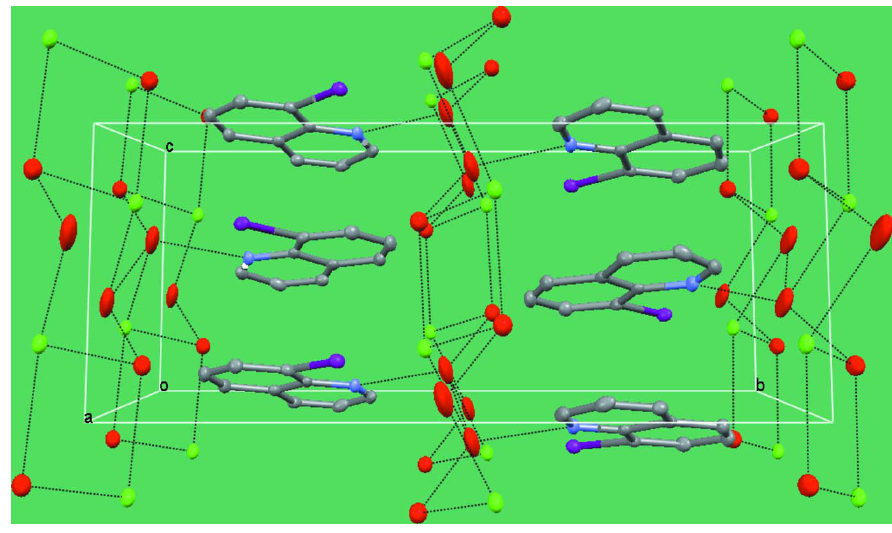
The crystal structure of 8-iodoquinolinium chloride dihydrate, viewed approximately along the a axis. Dotted lines represent hydrogen bonds. H atoms have been omitted for clarity. Displacement ellipsoids are drawn at the 50% probability